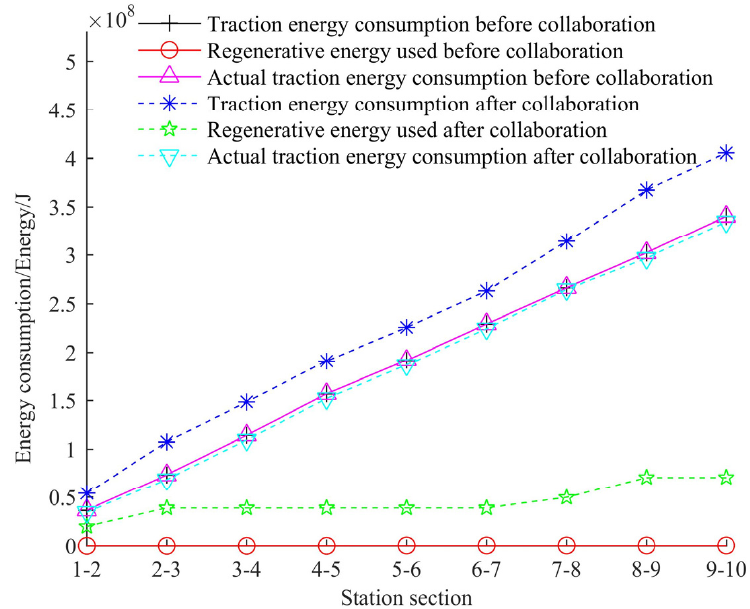
Figure 9. Energy consumption simulation diagram of Train 2.